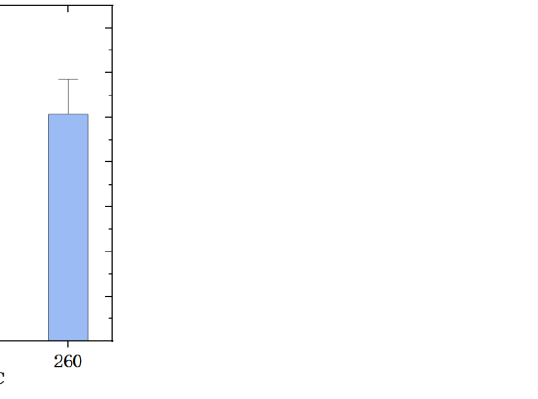
Figure 7. AC breakdown strength of oil-impregnated paper with different hot pressing temperatures.